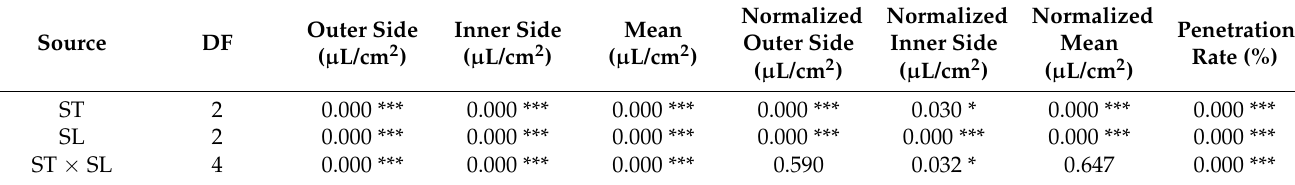
Table 4. ANOVA results ( p -values) for variables and interactions to assess DD volume.